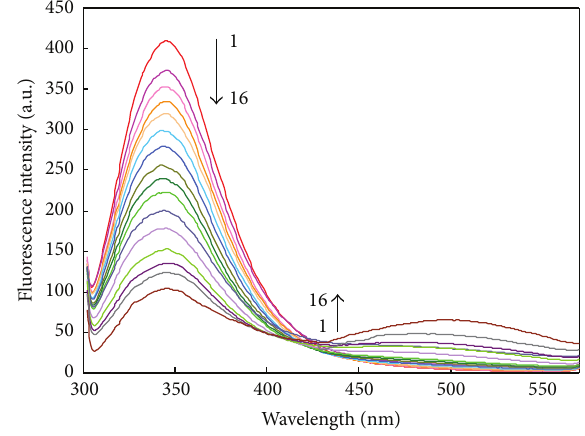
Figure 3: Effect of isoimperatorin on fluorescence spectra of HSA ( 𝑇 = 298 K, pH: 7.5). Curve (1): 3.0 𝜇 M HSA; Curves (2–16): 3.0 𝜇 M HSA in the presence of 0.2, 0.4, 0.6, 0.8, 1, 1.5, 2, 2.5, 3, 4, 5, 6, 7, 8, and 10 𝜇 M of isoimperatorin.